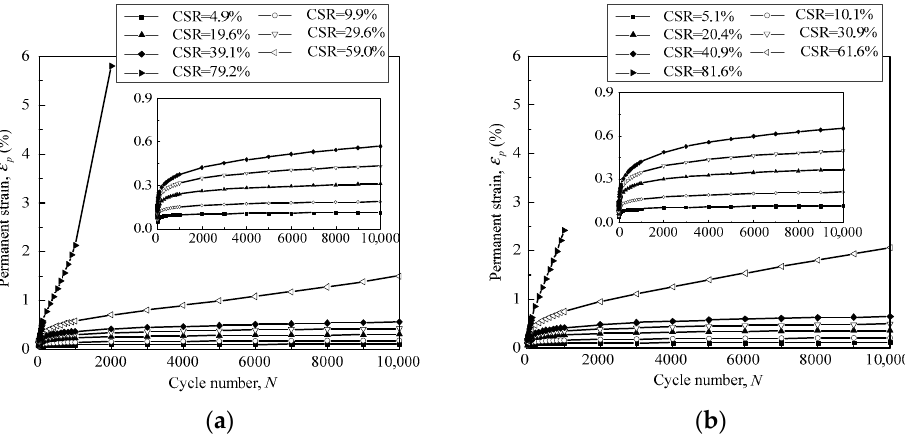
Figure 7. The relationship between permanent strain and loading cycles of granular samples with DoC = 1.00 under the confining pressure of ( a ) 40 kPa; and ( b ) 60 kPa.